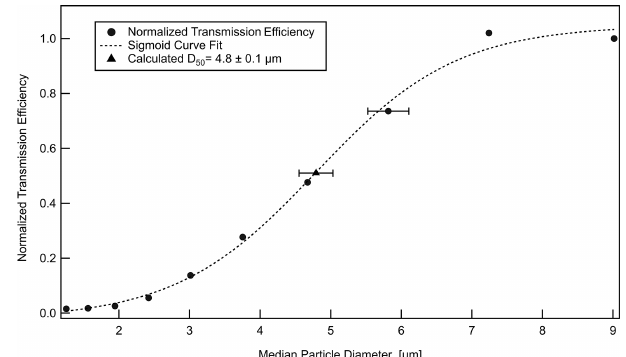
Figure 9. Transmission efficiency from SPIDER as a function of particle aerodynamic diameter (solid circles) fit with a sigmoid (solid line). The triangle represents the size at which 50% of parti- cles are transmitted (the experimental D50). The representative er- ror, ± 5%, due to instrument uncertainty, is shown on a point close to the D50 and on the D50. Note that the SPIDER transmission ef- ficiency represents the sequential transmission of the L-PCVI and